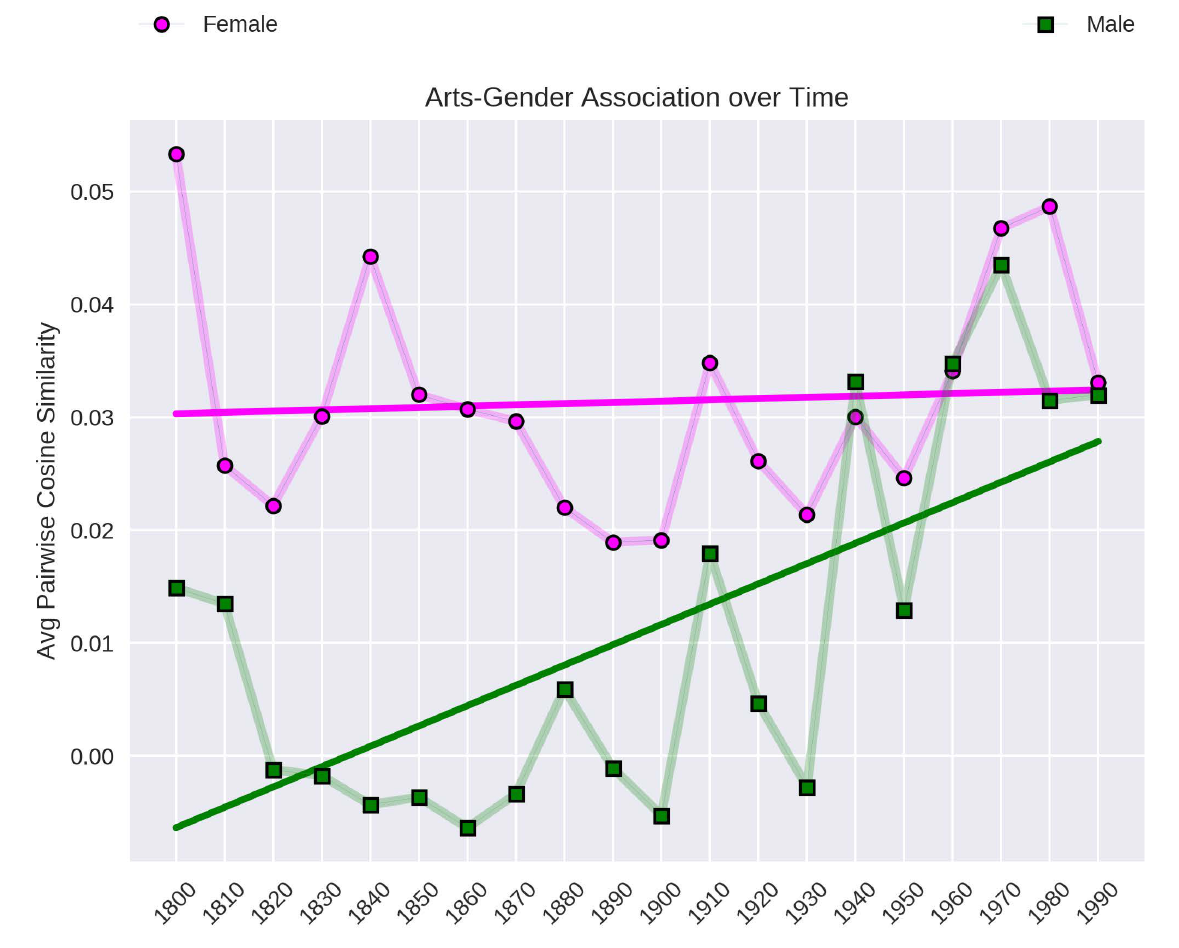
Figure 6: Female association and male association with the Arts domain measured by decade. The x axis is labeled with the first year of each decade (e.g., the label “1910” is used to mark the measurement based on the word embedding trained on text from 1910 up to but not including 1920). Avg,